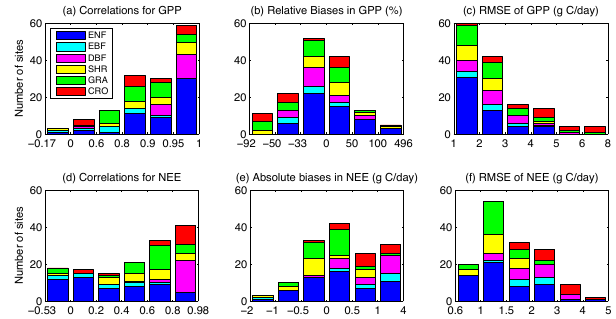
Figure 4. Bar charts of (a, d) correlation coefficients ( R ), (b, e) biases, and (c, f) RMSE for monthly (a–c) GPP and (d–f) NEE be- tween simulations and observations at 145 sites. Each bar represents the number of sites where the R , bias, or RMSE of simulations fall between the specific ranges as defined by the x axis intervals. The minimum and maximum of each statistical metric are indicated as the two ends of the x axis in the plots. The values of the x axis are not even. The absolute biases instead of relative biases are shown for NEE because the long-term average NEE (the denominator) is usually close to zero at most sites. The PFT definitions are as in Fig. 2. Detailed comparisons at each site are shown in Figs. S2 and S4.